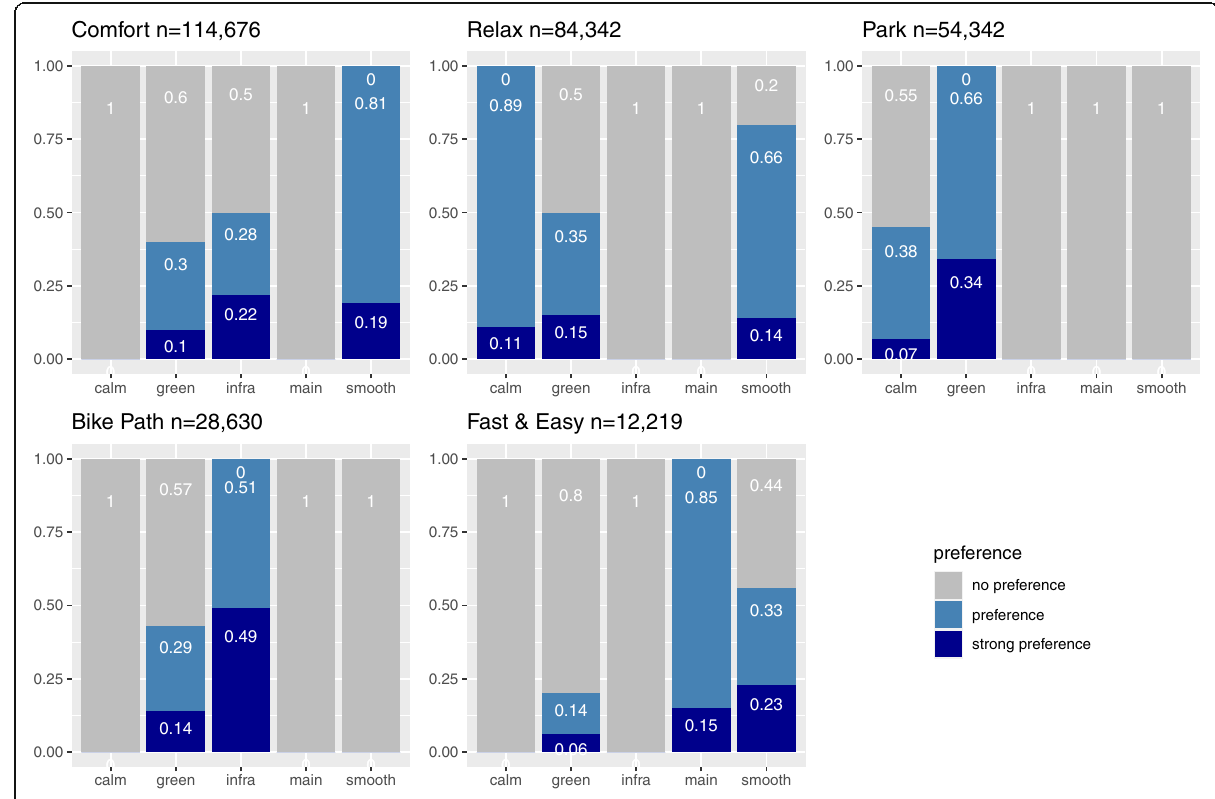
Fig. 12 Percentages of preferences in resulting